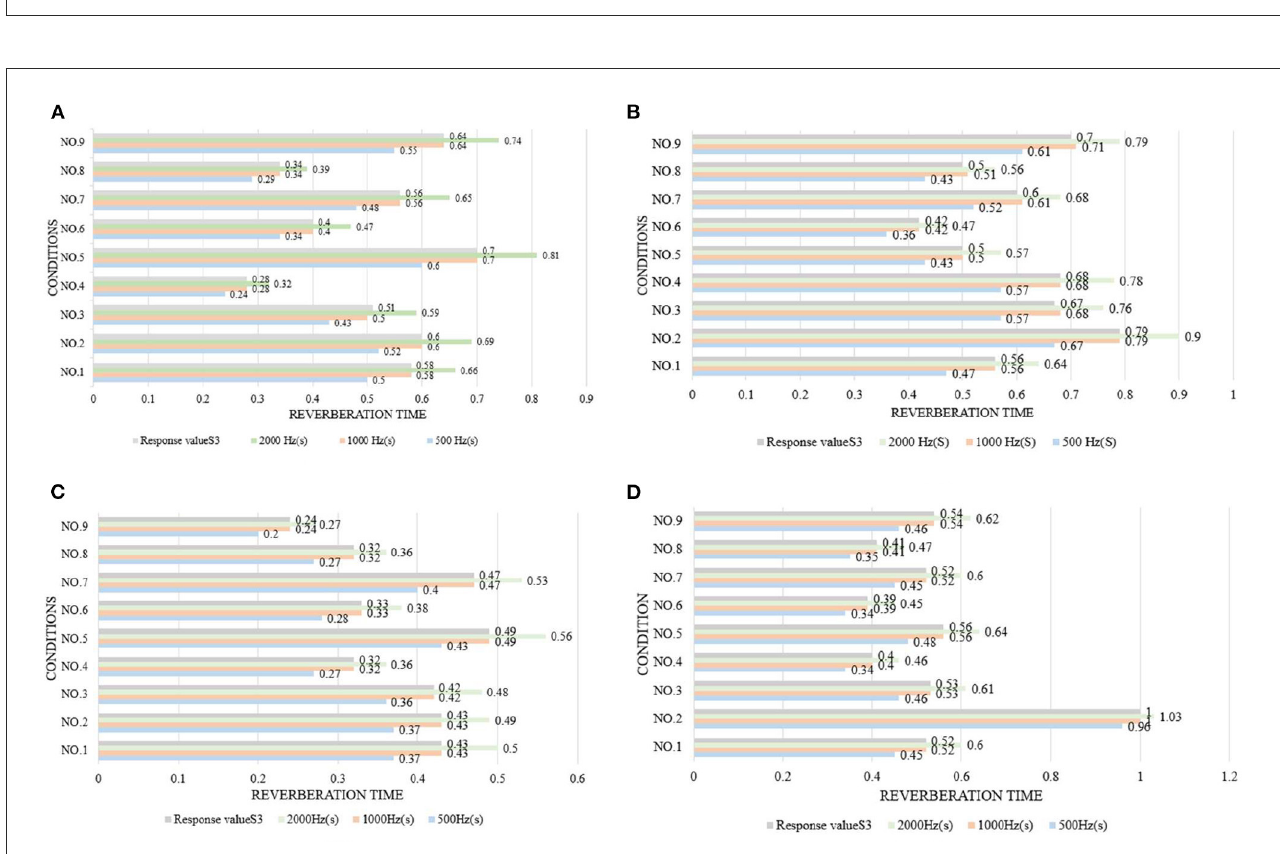
FIGURE5 Thermal environment simulation results and response values for (A) TUAI, (B) TCAI, (C) TCSI, and (D) THAI. Image source: self-drawn by the author.